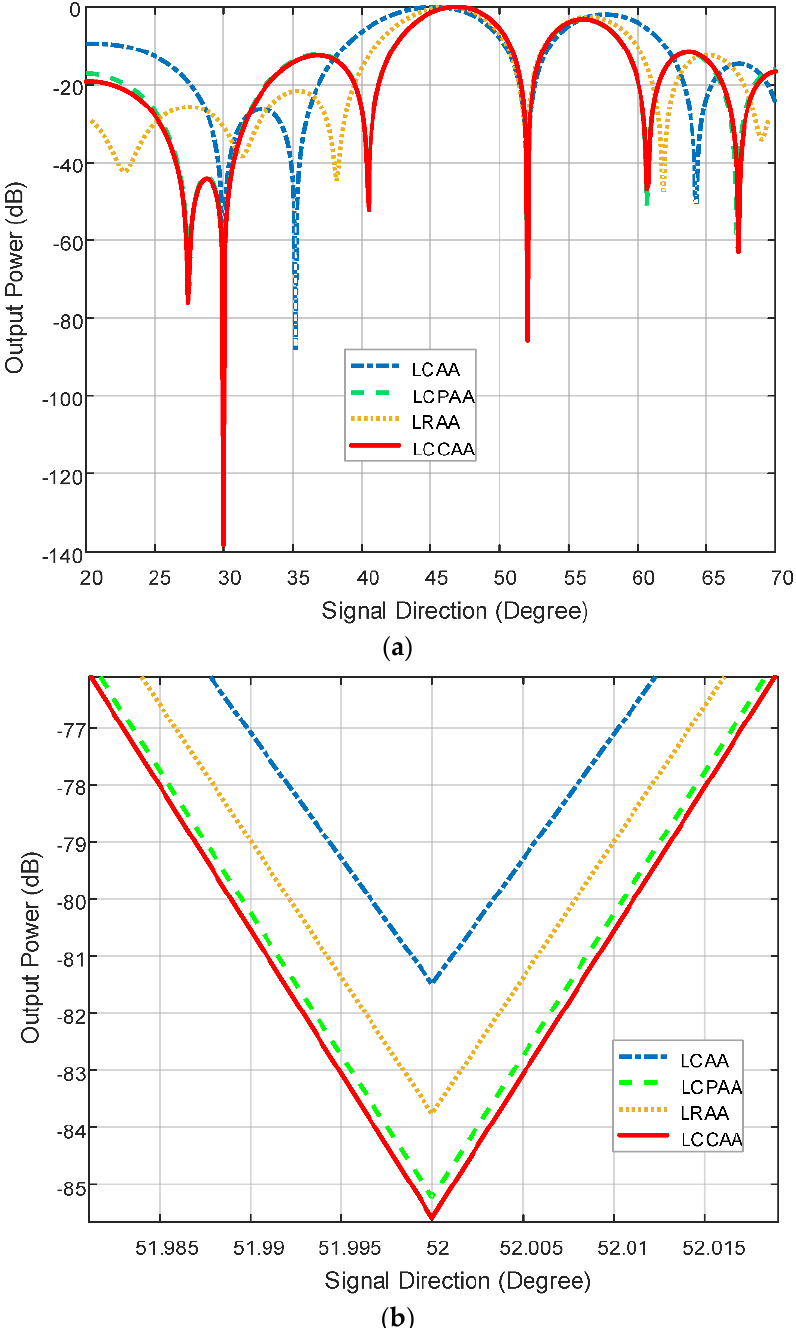
Figure 2. ( a ) Performance analysis of all beamformer applying optimal technique. ( b ) Output power of all beamformer applying optimal technique.